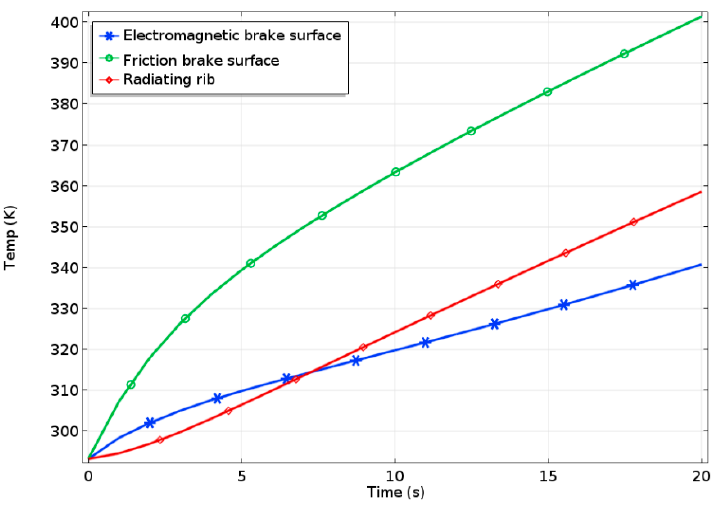
Figure 12. Temperature curves of the integrated brake disc.